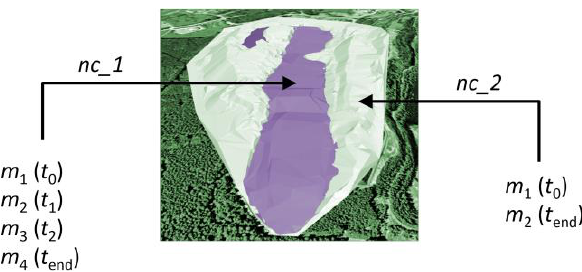
Figure 3. Different temporal discretizations for subregions of a 4D model (based on the Piesberg dataset by Lautenbach and Berlekamp (2002))